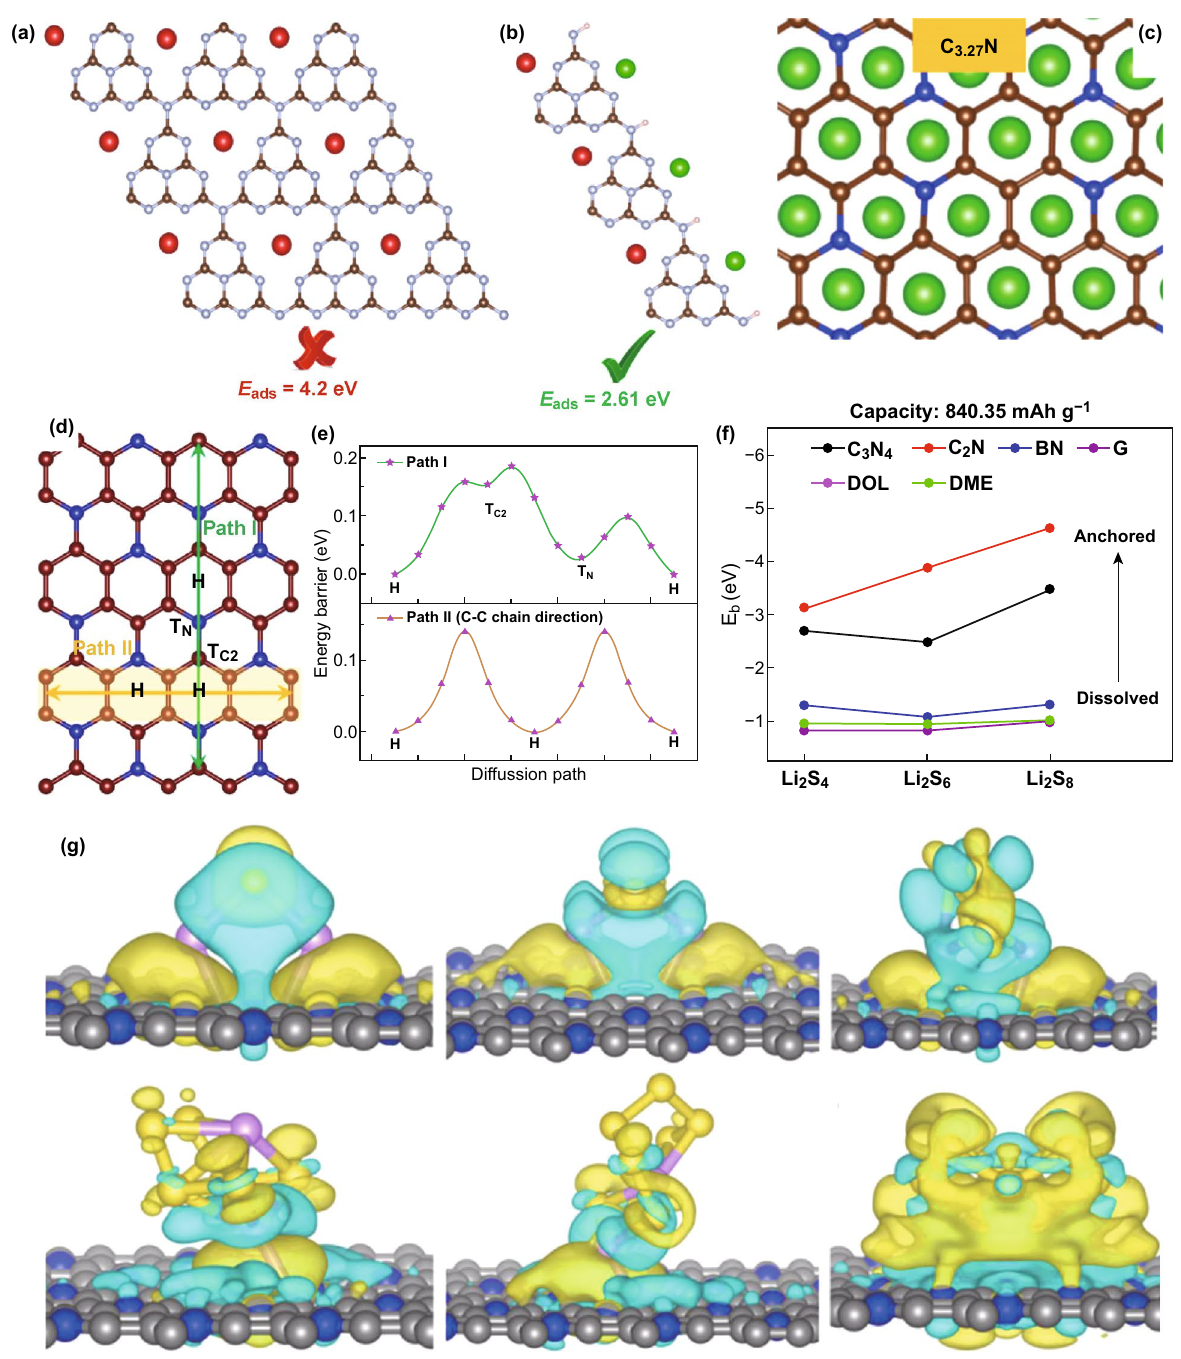
Fig. 7 Reversible Li active sites in a 2D-C 3 N 4 sheet, and b 1D-C 3 N 4 fiber. Green means reversible Li atoms and red means non-reversible Li atoms. c Top and side view of stable intercalation structures of n Li ions into C 3 N. Reproduced with permission from Ref. [40]. d Diffusion paths and e corresponding energy barriers of Li migration in C 3 N-S2. Reproduced with permission from Ref. [51]. f Binding energy of Li 2 S 4 / Li 2 S 6 /Li 2 S 8 interacting with G, BN, C 2 N, C 3 N 4 and DOL/DME solvent, respectively. Reproduced with permission from Ref. [17]. g Isosurfaces of charge density difference of